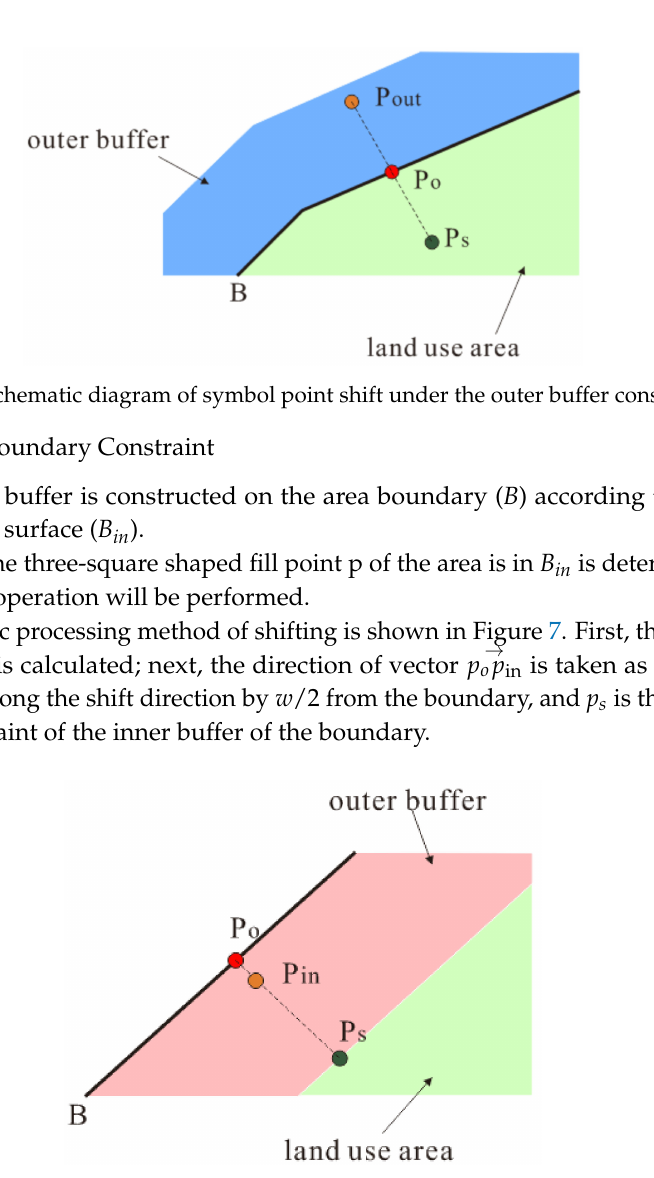
Figure 7. Schematic diagram of symbol point shift under the inner buffer